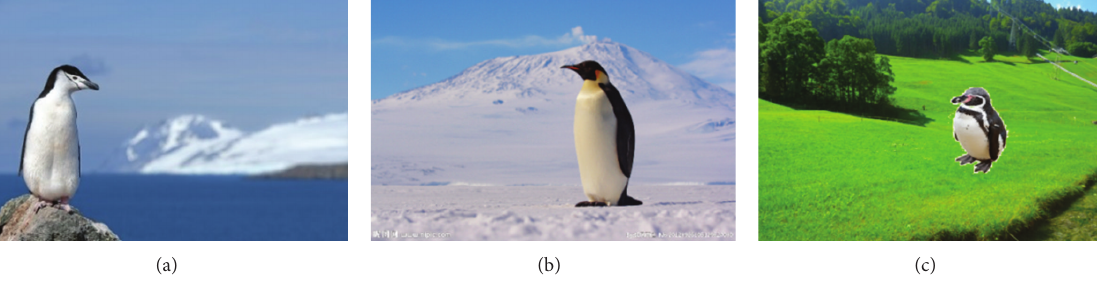
Figure 1: Consistent and inconsistent